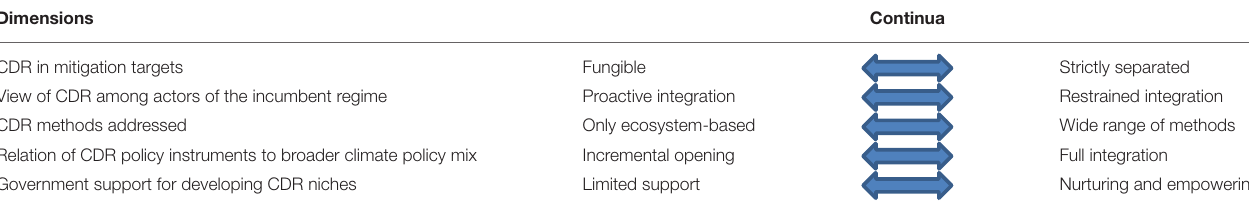
TABLE 2 | Five dimensions of CDR policy making and continua of observed manifestations.